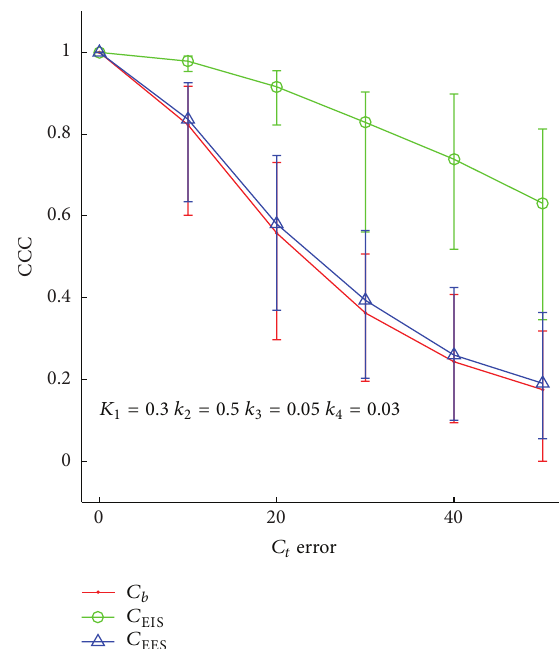
Figure 3: The concordance correlation coefficient between the estimated and true values of the time courses as a function of noise in the tissue curves for a single set of PET kinetic parameters. If the 𝐶 𝑡 error is less than 10 times the square root of activity level, then the CCC is greater than 0.75. Once 𝐶 𝑡 error is greater than this, the ability to faithfully reconstruct the time courses is substantially